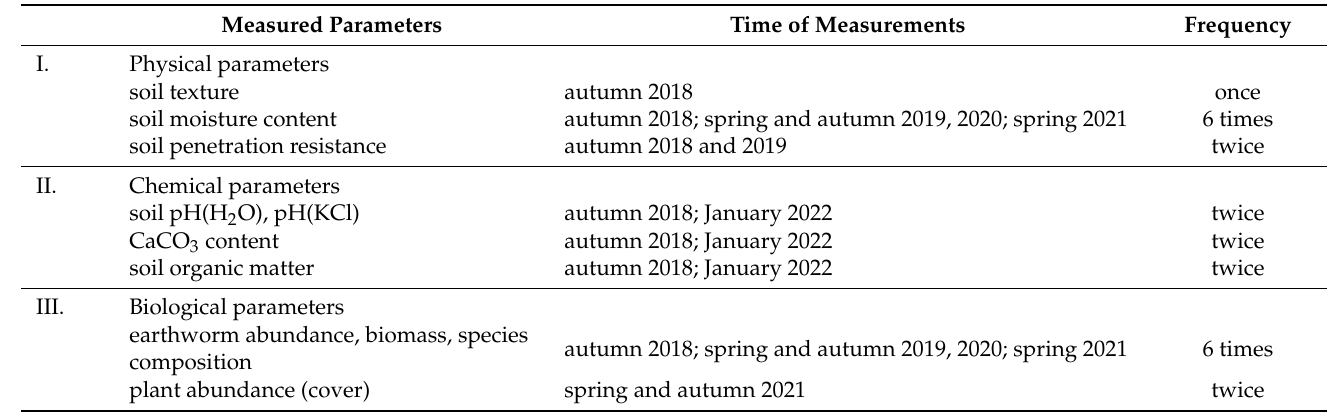
Table 1. Summary of the examined soil parameters, time of sampling and sampling frequency ( ˝Osag á rd,